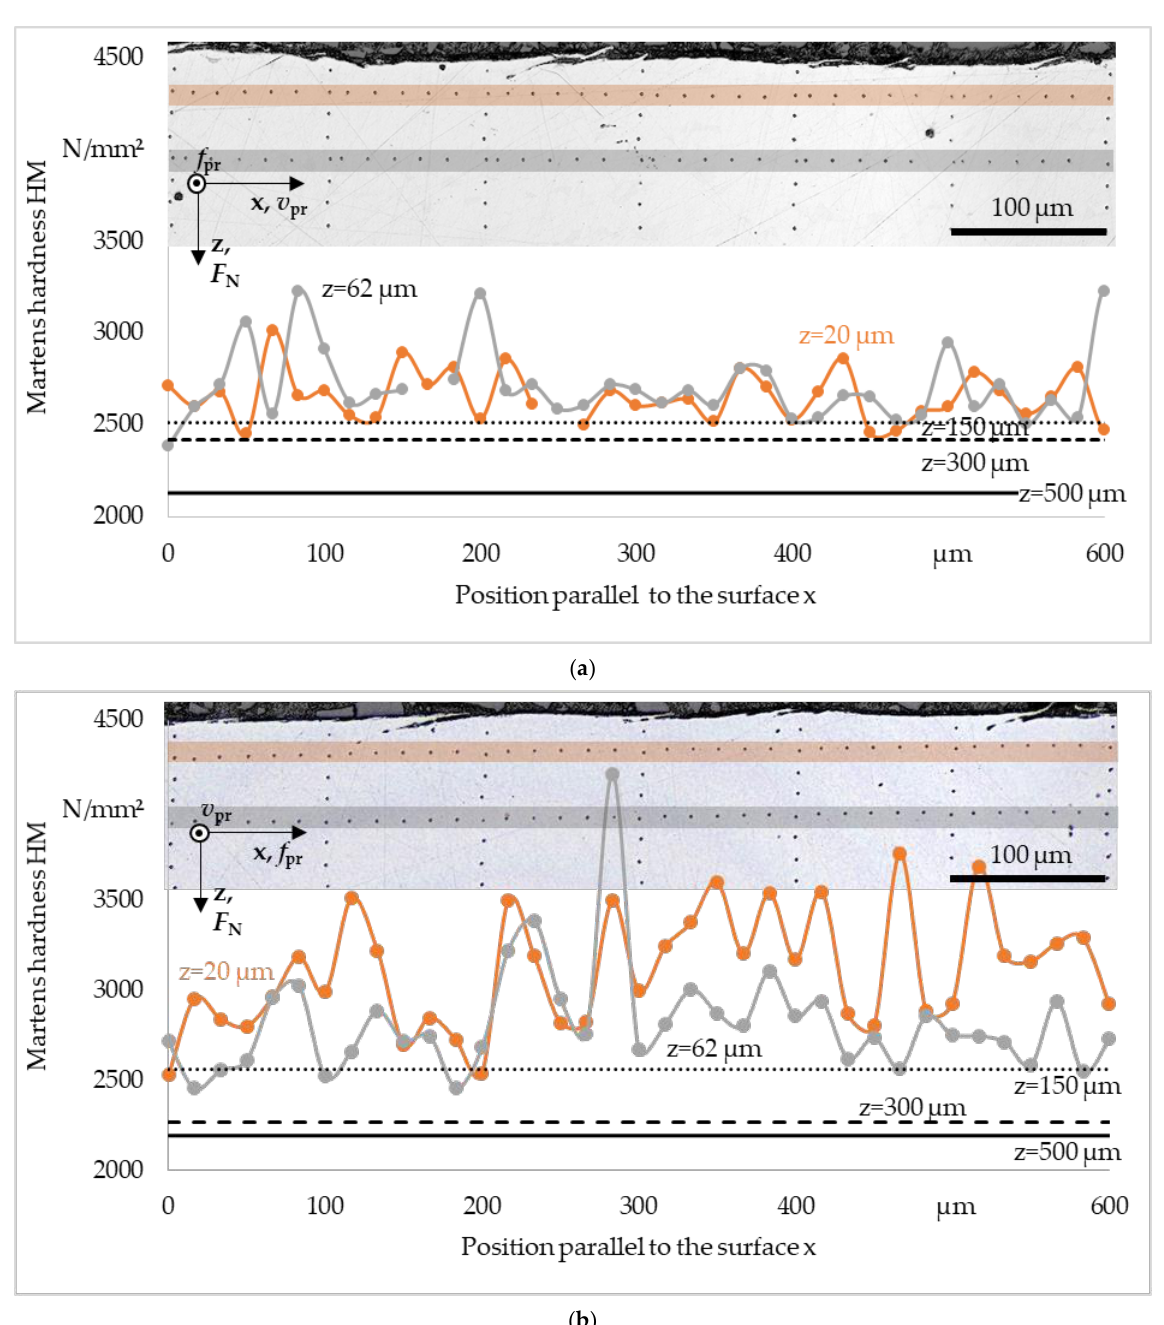
Figure 13. Hardness values determined in various distances z to the surface by instrumented microhardness measurement: ( a ) in processing direction; ( b ) perpendicular to processing direction. Experiment ID = A6.